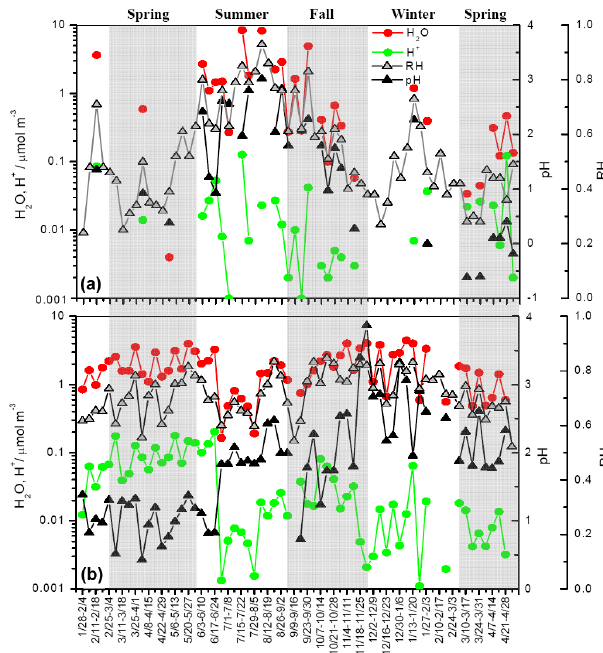
Fig. 2. Seasonal variations of in situ PM 2 . 5 pH, [H + ] Ins , [H 2 O] and RH at (a) Beijing and (b)